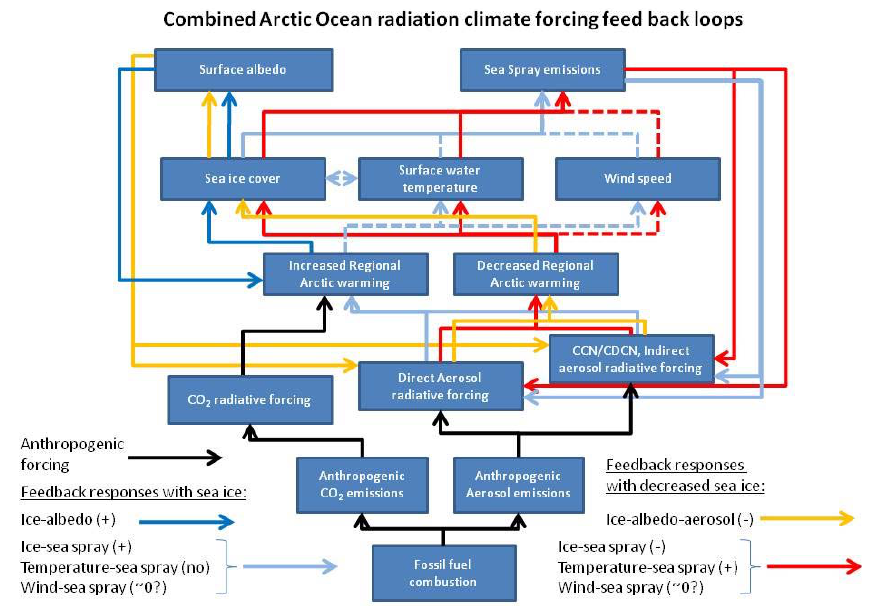
Fig. 1. Schematic representation of the processes involved in the Arctic sea ice-albedo and sea ice-aerosol feedback mechanisms. Black lines represent anthropogenic forcing and blue lines represent the usual sea ice-albedo positive feedback. Light blue and red lines represent the sea ice-aerosol feedbacks (positive and negative respectively) and the yellow lines indicate how the sea ice-albedo and sea ice-aerosol feedback loops are coupled. (+) Indicates an overall positive feedback effect, ( − ) an overall negative, and (0?) a small or uncertain